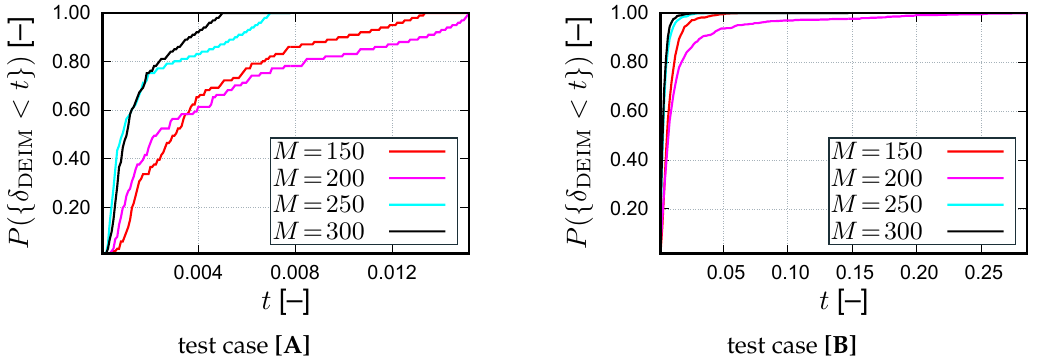
Figure 4. Statistical distribution function of the relative error of the DEIM for different numbers of magic points M 150,200,250,300 (dimension of POD basis: m = ∈ { }